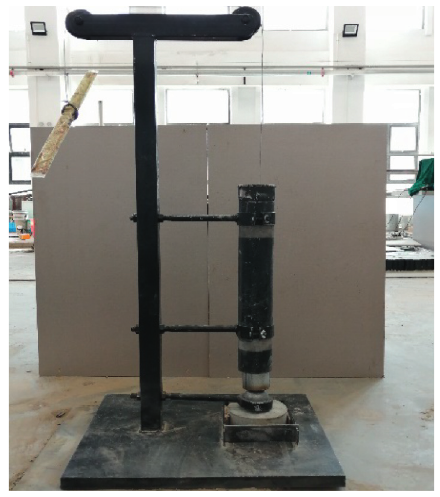
Figure 4: Drop weight impact test